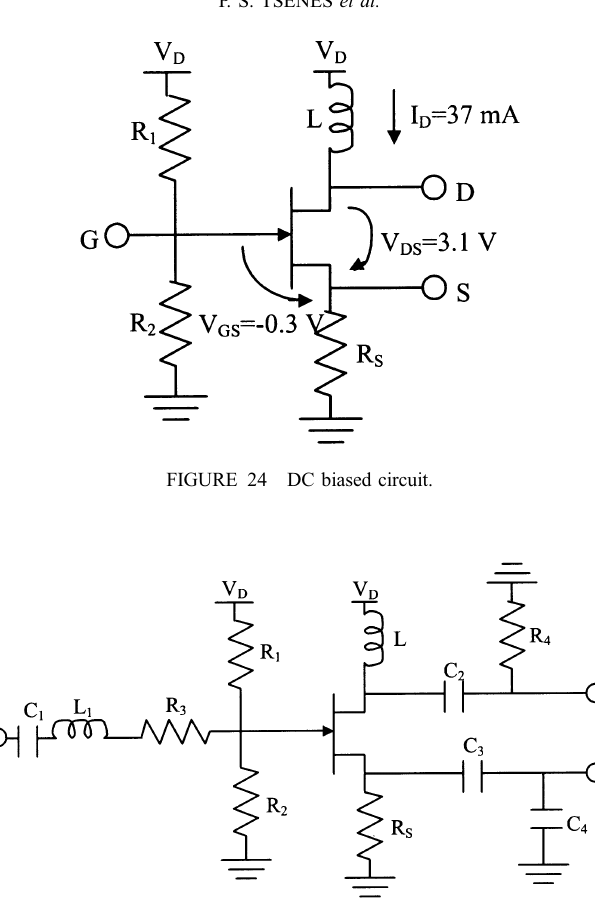
FIGURE 25 DC biased and matched circuit.